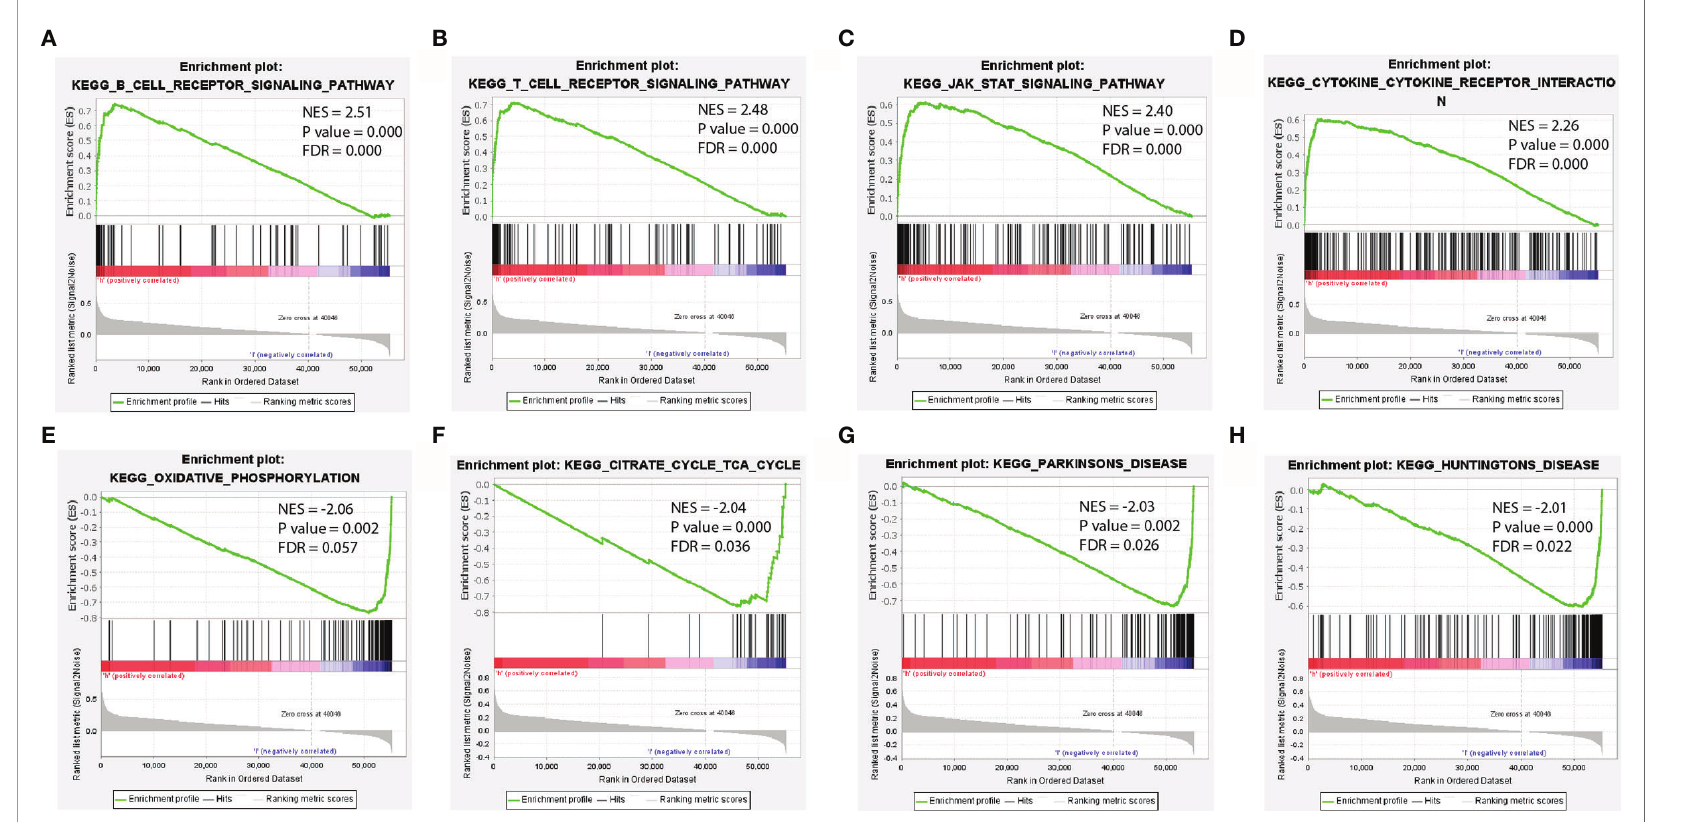
FIGURE 3 | Enrichment plots from GSEA. (A – D) The most signi fi cant enrichment pathways with high IRF4 gene expression in LUAD. (E – H) The most signi fi cant enrichment pathways with low IRF4 gene expression in LUAD. GSEA, gene set enrichment analysis; LUAD, Lung